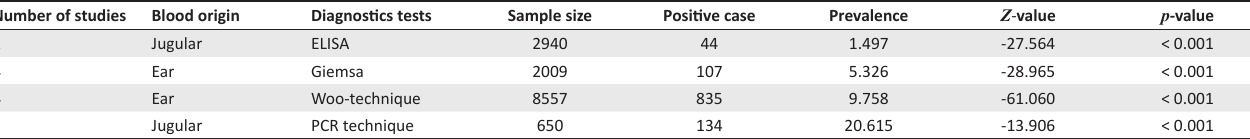
TABLE 2-A1: Pooled prevalence estimates of bovine trypanosomiasis respect by diagnostic methods. Number of studies